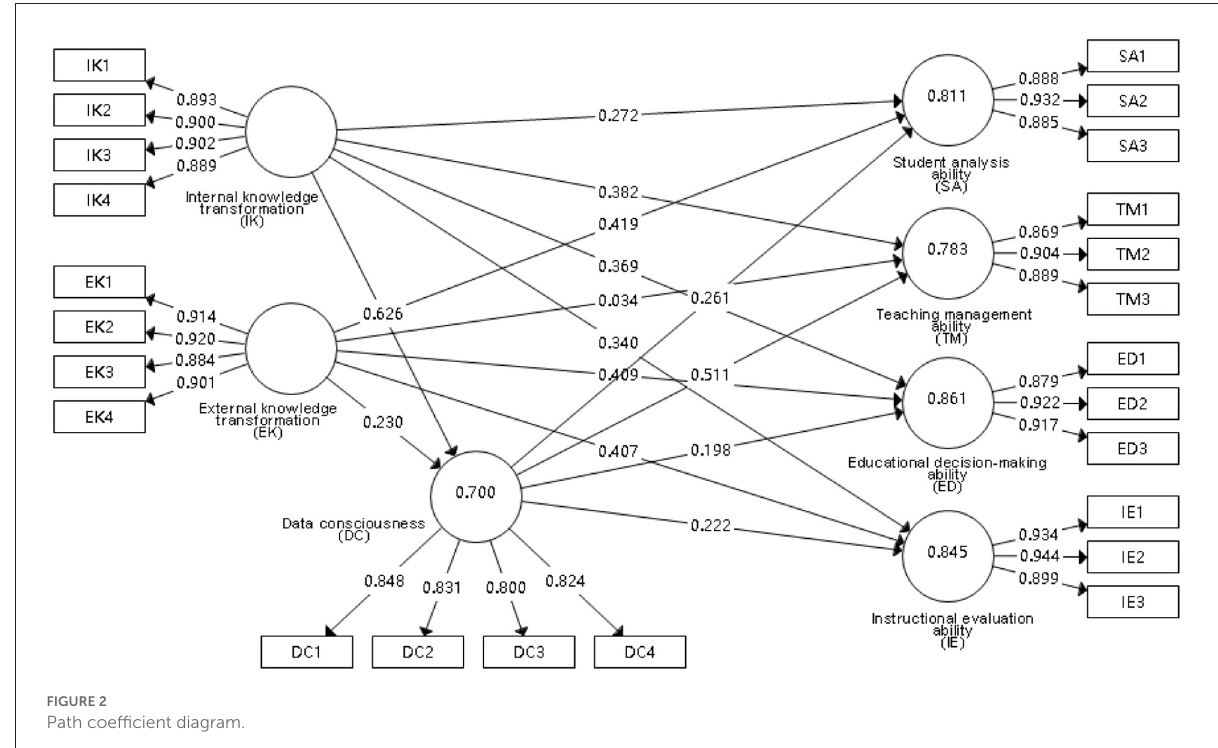
FIGURE2 Path coefficient diagram.